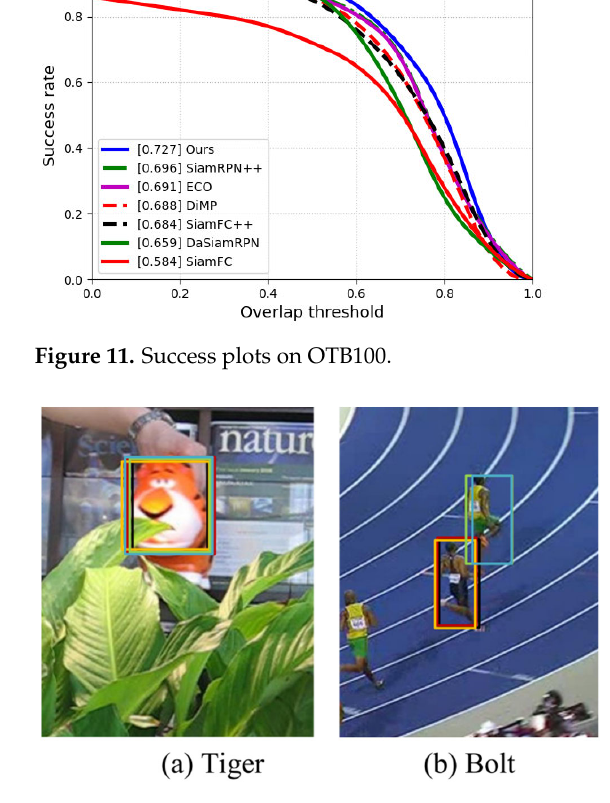
Figure 12. Candidate objects and correction process. In the figure, the red box represent the targets with the highest similarity scores, i.e., the tracking results, and the rest of the color boxes are the candidate targets ranked from 2 to 5.